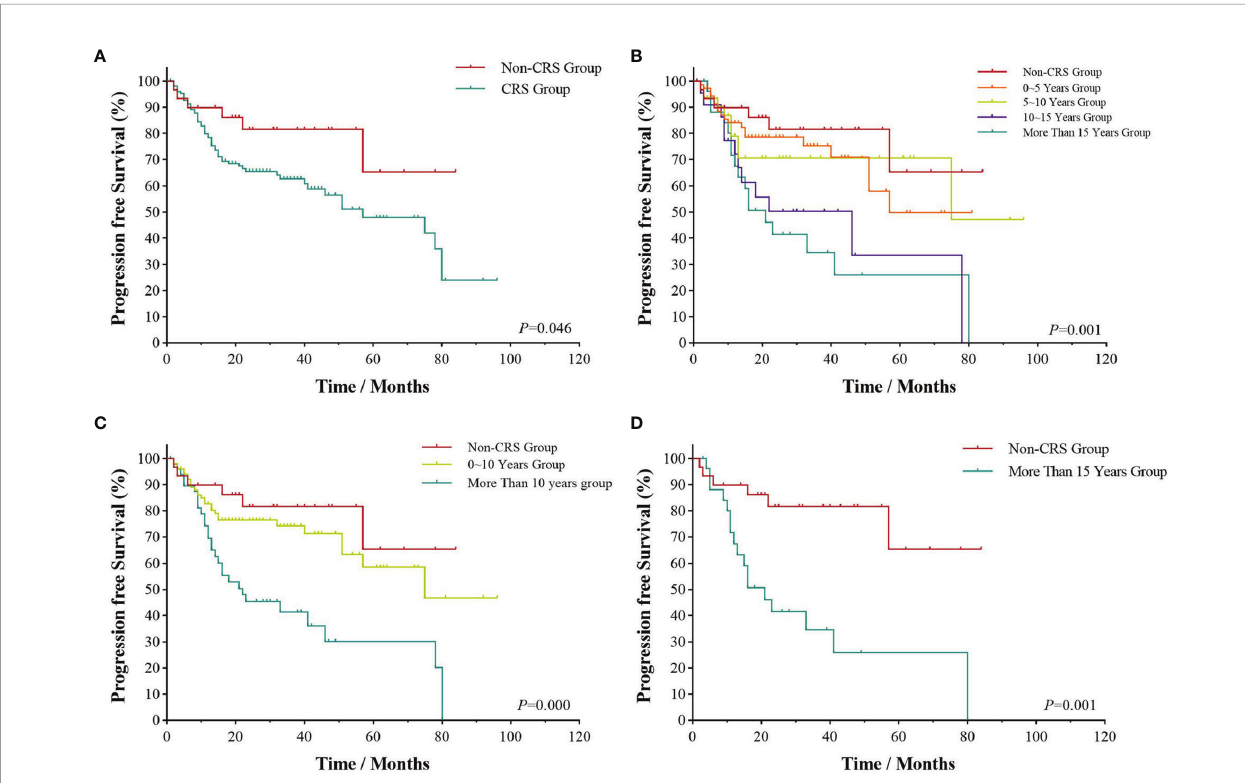
FIGURE 2 | Survival analyses by CRS history. Progression-free survival (A) of UAT-ENKTL patients with non-CRS group versus CRS group; progression-free survival (B) of UAT-ENKTL patients according to the length of CRS history (non-CRS group, 0 – 5 years group, 5 – 10 years group, 10 – 15 years group, more than 15 years group); progression-free survival (C) of non-CRS group, 0 – 10 years group, and more than 10 years group of all 182 UAT-ENKTL patients; progression-free survival (D) of UAT-ENKTL patients with non-CRS group and more than 15 years group. CRS, chronic rhinosinusitis; ENKTL, natural killer/T-cell lymphoma, nasal type; UAT, upper aerodigestive tract.